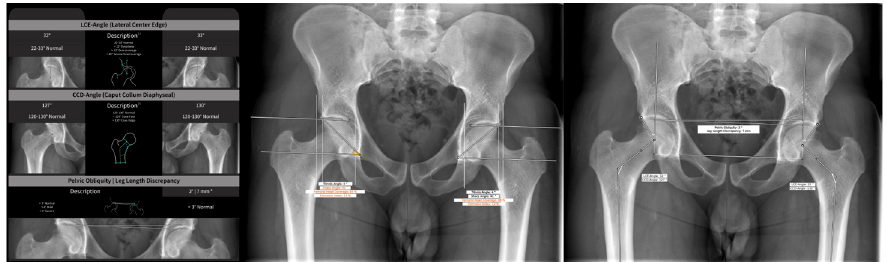
Figure 2. AI software (HIPPO™) report of an AP radiograph of the pelvis providing fully automated measurements.